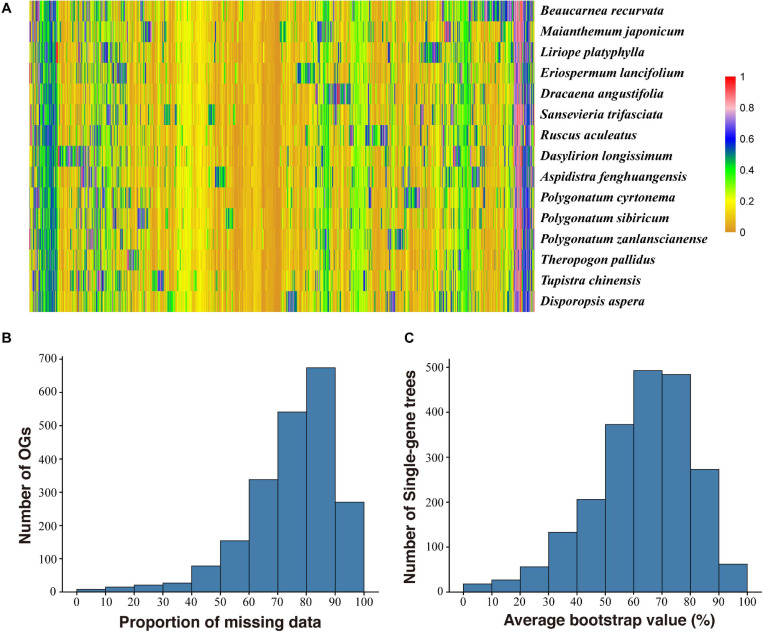
Frequency of missing data of each orthogroup (OG) in each taxon (A), distribution of missing data in the OGs (B), and average bootstrap value of single gene tree (C). Each row corresponds to a taxon and each column corresponds to an OG in (A).